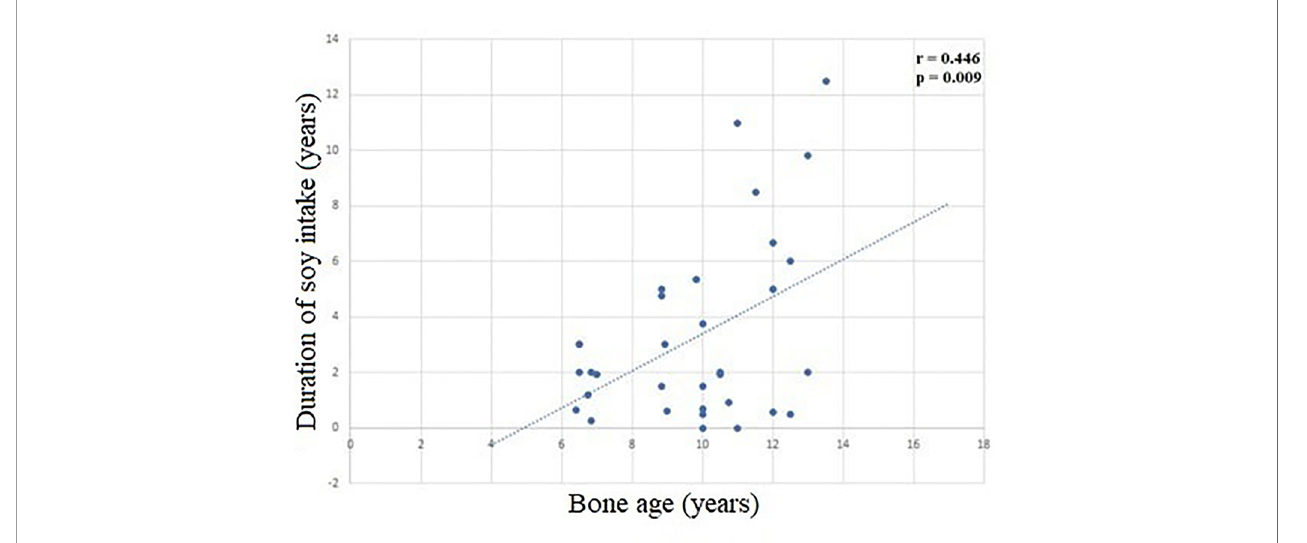
FIGURE 2 | Correlation between duration of soy intake e and bone age (r = 0.446, p =